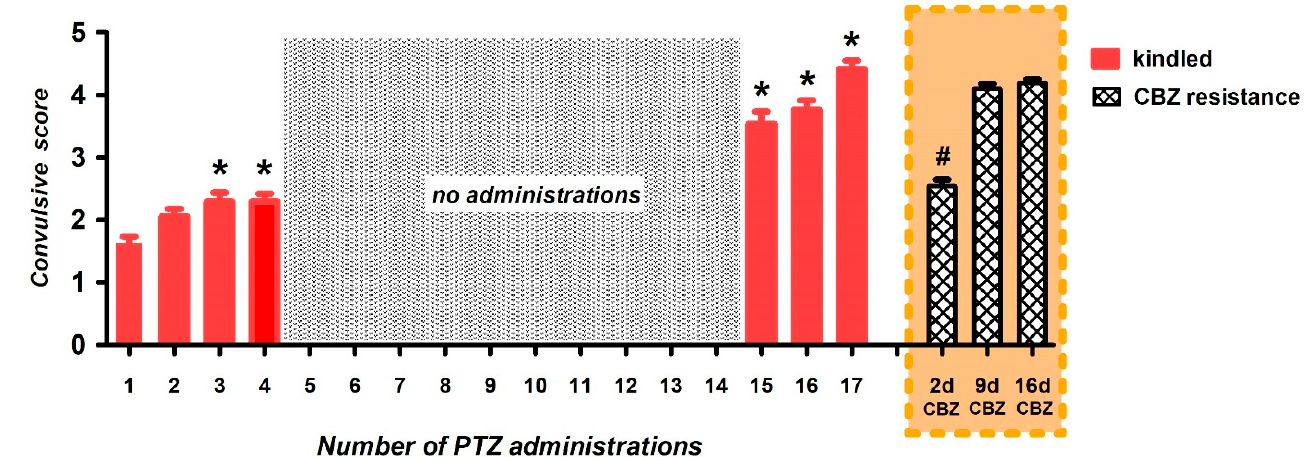
Figure 1. To induce window-PTZ kindling, rats were administered with a subthreshold dose of PTZ (35 mg/kg i.p.) three times/week. With this protocol, we obtained fully kindled rats (red bars). Next, fully kindled rats were treated with a single dose of CBZ (40 mg/kg i.p.) at 2, 9 and 16 days after their last kindling stimulation (orange box), thus obtaining CBZ-resistant rats (grid bars). Data represent mean ± SEM; * p < 0.05, which is significantly different from the first assay in the kindled group; # p < 0.05, which is significantly different from the kindled condition. Pentylenetetrazole (PTZ), carbamazepine (CBZ).